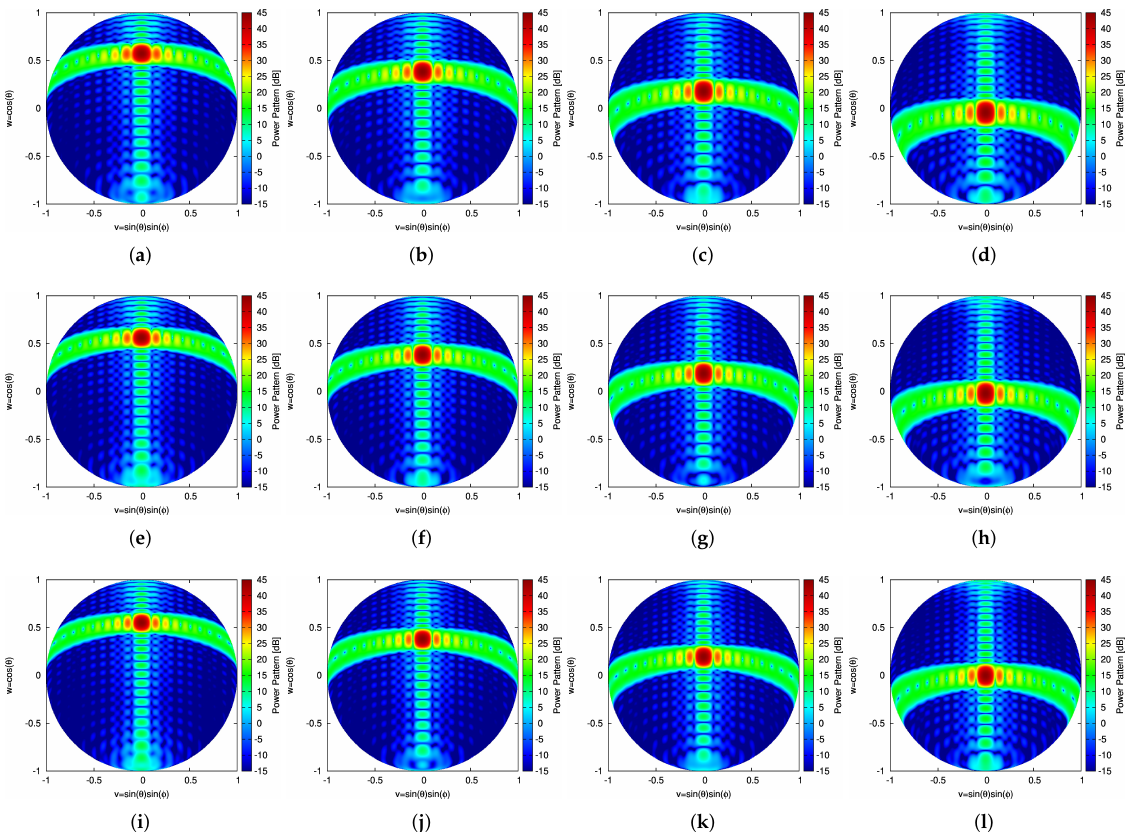
Figure 10. Numerical Assessment (Sparse CPA, M = 16, d = λ pattern in the ( v , w )-plane of the ( a , e , i ) b = 1, ( b , f , j ) b = 3, ( c , g , k ) b = 5, and ( d , h , l ) b = 7 beams